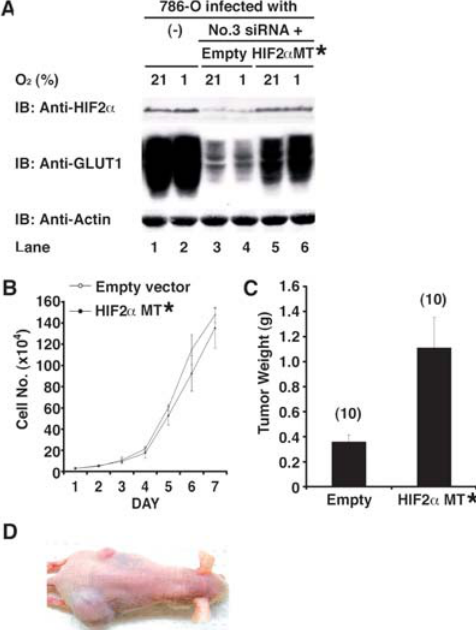
Figure 3. Effect of HIF2 a shRNA Is Specifically Due to Downregulation of HIF2 a (A) Parental 786-O cells ( VHL [ (cid:1) / (cid:1) ]) and 786-O cells stably producing HIF2 a shRNA #3 that were coinfected with an empty retrovirus (Empty) or a retrovirus encoding a HIF2 a mRNA with three silent mutations in the #3 recognition site (MT*) were grown in the presence of 21% or 1% oxygen and immunoblotted (IB) with the indicated antibodies. (B) In vitro proliferation of 786-O HIF2 a shRNA #3 cells infected with the indicated retroviruses. (C) Tumor weights approximately 9 wk after subcutaneous implanta- tion of 786-O HIF2 a shRNA cells infected with the indicated retroviruses in nude mice. Number of tumors analyzed is shown in parentheses. Error bars ¼ one standard error. (D) Representative photograph of nude mouse 9 wk after subcuta- neous injection of 786-O HIF2 a shRNA #3 cells in left (upper) flank and 786-O HIF2 a shRNA #3 cells infected with retrovirus encoding HIF2 a MT* mRNA on right (lower) flank. DOI: